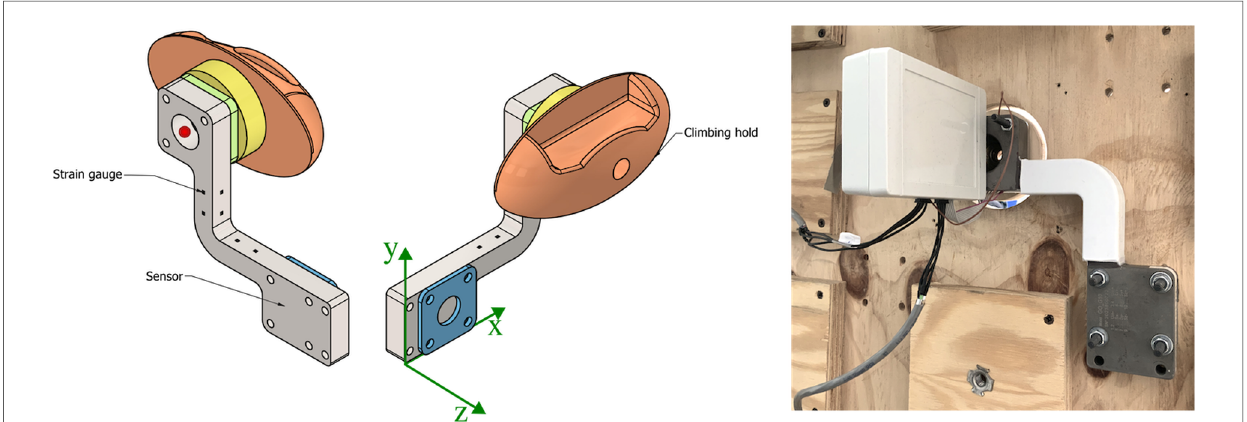
FIGURE 2 Sensor components, on the left, and a picture of a mounted sensor, taken from behind the wall. In the drawing, the sensing element is represented in gray and the strain gauges in black, the green and blue components are spacers, while the yellow component is a wooden disk. The green reference frame refers to the axes used in the sensor characterization, and the red point on the top left of the fi gure is the reference with respect to which testing offsets are measured, as described in the Experimental Design section. In the picture, the box on the left encases the acquisition board and is permanently attached to the sensing